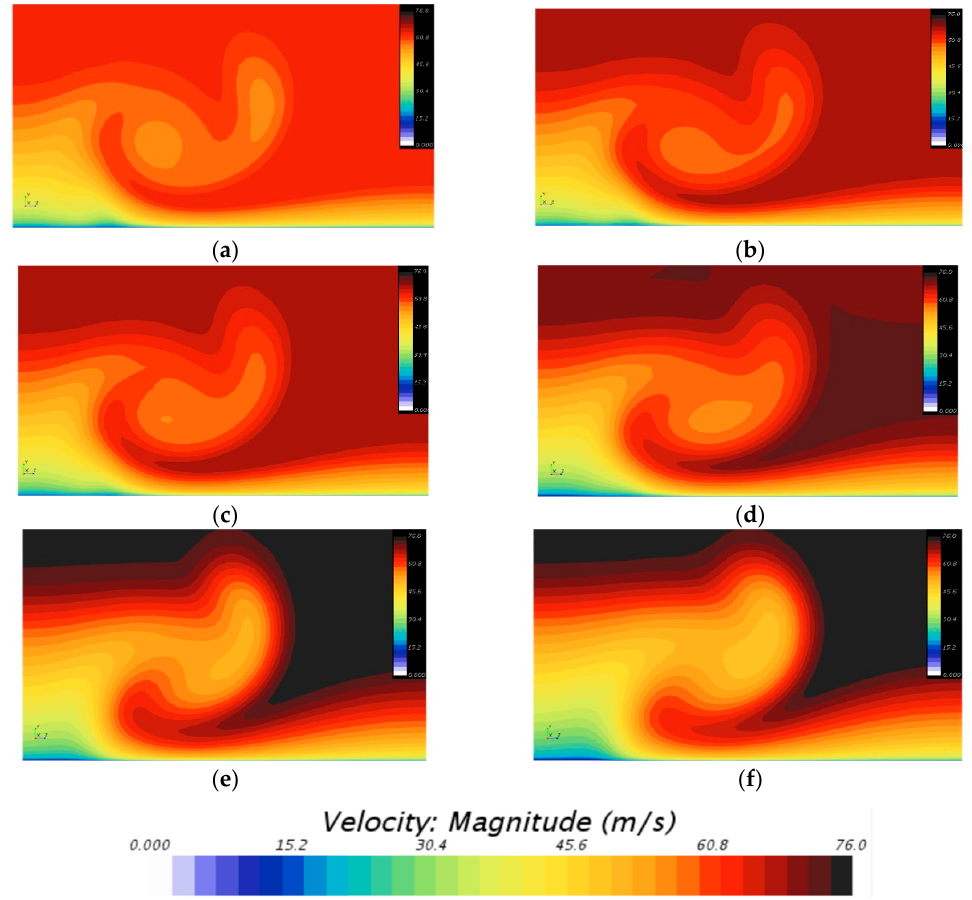
Figure 12. Axial velocity fields at angles of attack of ( a ) 0°, ( b ) 4°, ( c ) 6°, ( d ) 10.37°, ( e ) 15.25°, and ( f ) 18.18° measured in a spanwise plane placed five device heights downstream of the VG.